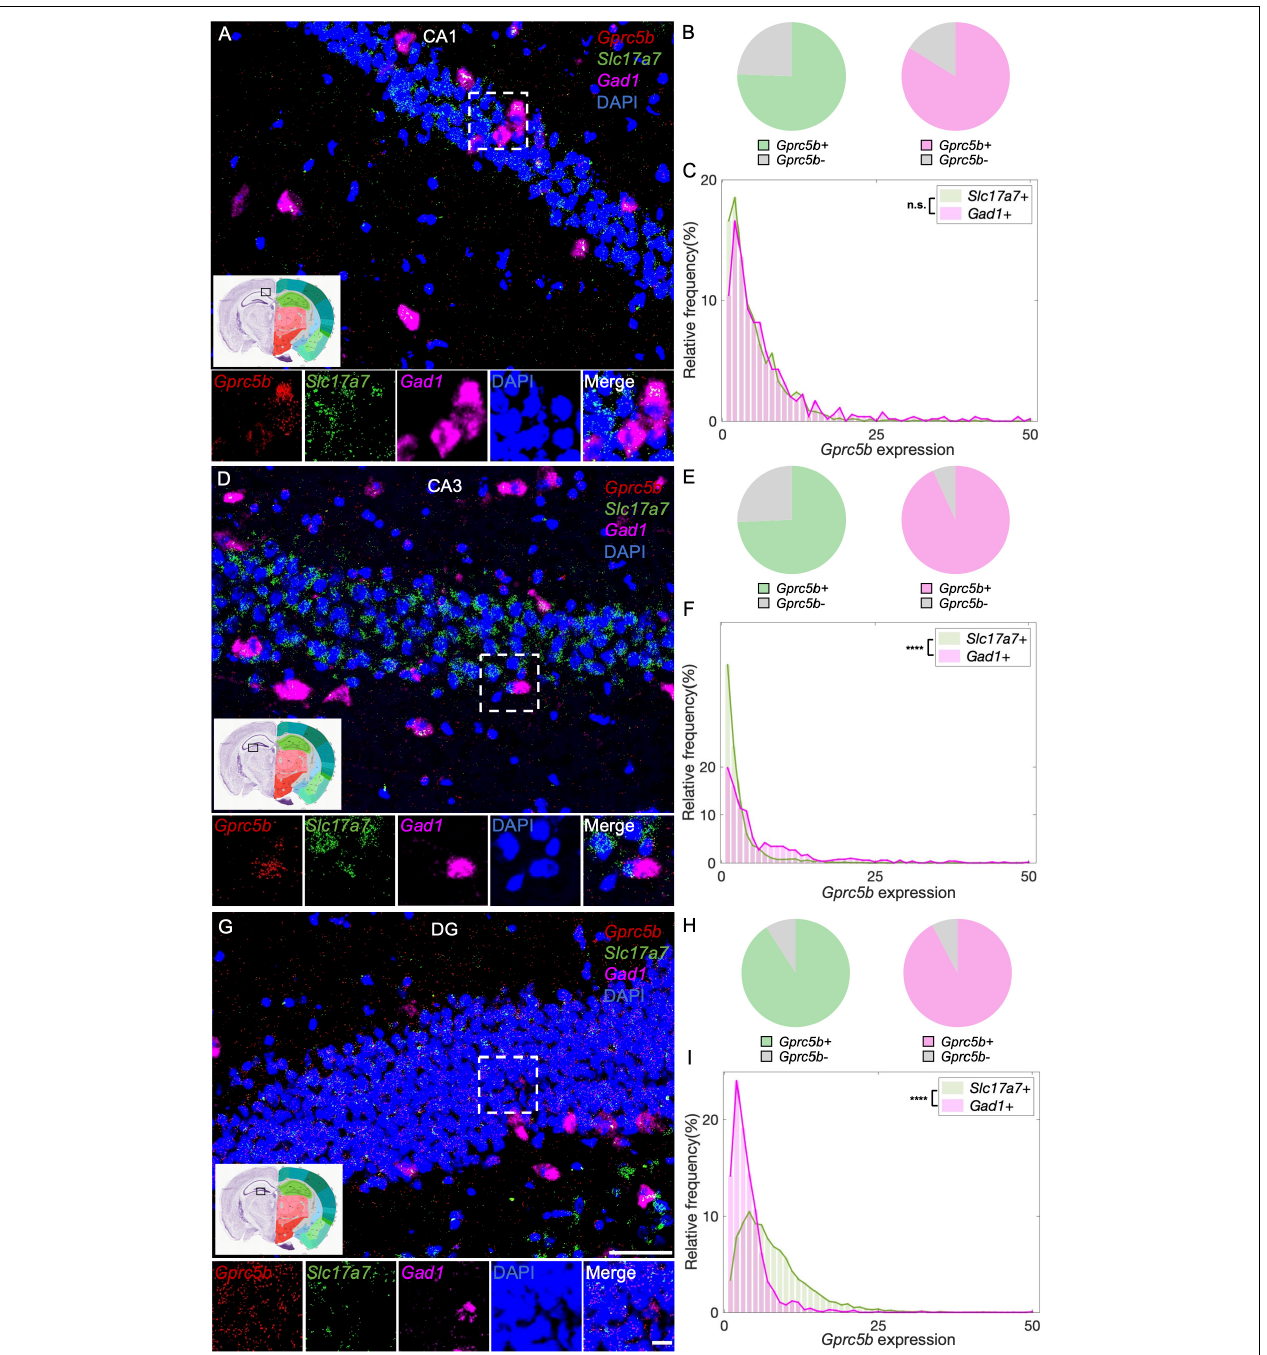
FIGURE 7 | Three hippocampal regions display distinct patterns of distribution of Gprc5b mRNA within excitatory and inhibitory neurons. Representative in situ hybridization images showing Gprc5b mRNA distribution in CA1 (A) , CA3 (D) , and DG (G) . Gprc5b was probed in red, glutamatergic neurons marked by Slc17a7 probe in green, GABAergic neurons indicated by Gad1 probe in magenta, nuclei by DAPI in blue. Pie charts show fractions of Gprc5b positive neurons in each of the glutamatergic or GABAergic neuronal populations, across CA1 (B) , CA3 (E) , and DG (H) . (C) Frequency distribution analysis demonstrating Gprc5b mRNA expression in CA1 within glutamatergic and GABAergic neuronal populations (Bin width = 1, sampled from 2033 glutamatergic neurons and 538 GABAergic neurons of 2–4 animals, p = 0.6486). (F) Frequency distribution analysis of Gprc5b mRNA expression in CA3 within glutamatergic and GABAergic neurons (Bin width = 1, sampled from 1759 glutamatergic neurons and 520 GABAergic neurons of 2–4 animals, p < 0.0001). (I) Frequency distribution analysis of Gprc5b mRNA expression in DG within glutamatergic and GABAergic neurons (Bin width = 1, sampled from 4640 glutamatergic neurons and 1426 GABAergic neurons of 2–4 animals, p < 0.0001). Scale bar: 50 µ m; scale bar of magnified images: 10 µ m; reference brain images are retrieved from Allen brain atlas. Two-sided Wilcoxon–Rank sum test was conducted to compare expression within neuronal populations. **** p <